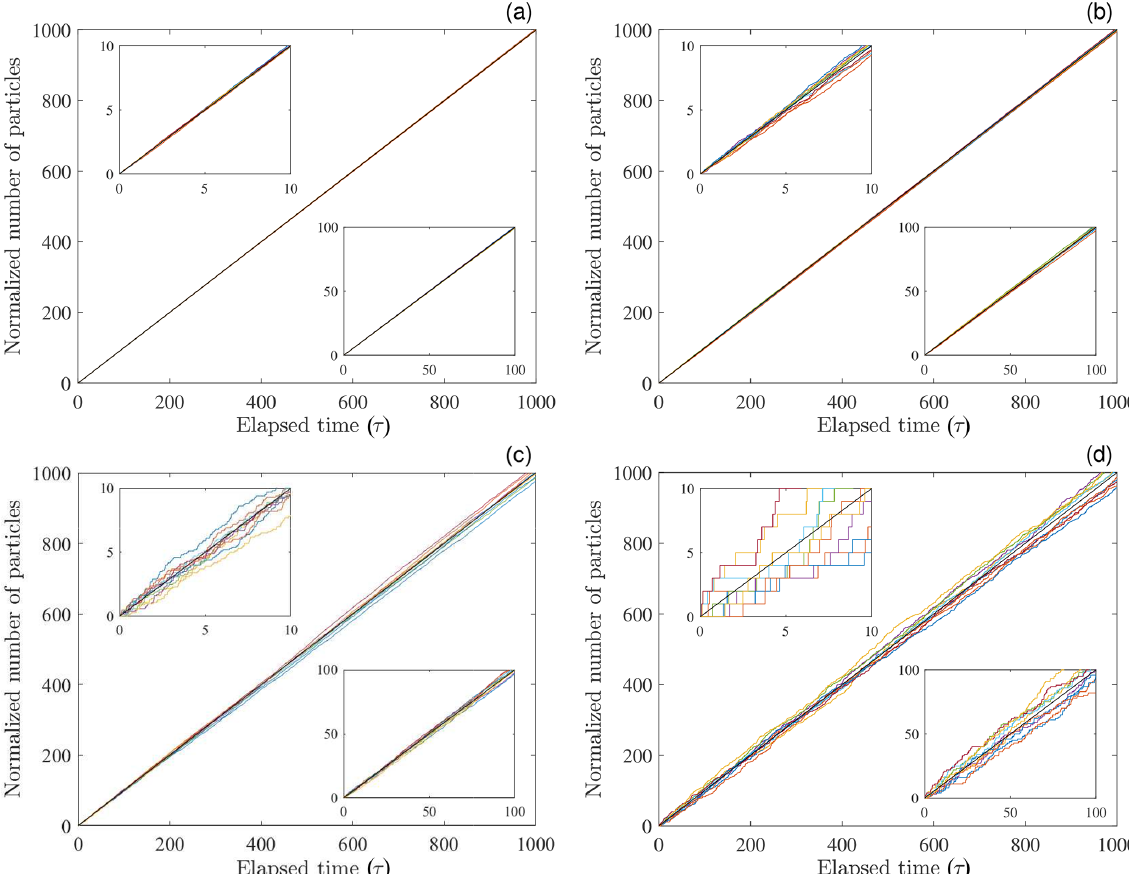
Figure 3. Plot of 10 realizations (colored lines) of normalized number ˆ n ( x ) versus elapsed time τ showing increasing variance with τ . Plots generated with (a) η = 1000, (b) η = 100, (c) η = 10 and (d) η = 1. Black line represents ensemble expected values of ˆ n ( x ). Compare with Fig. 2 in Ancey and Pascal